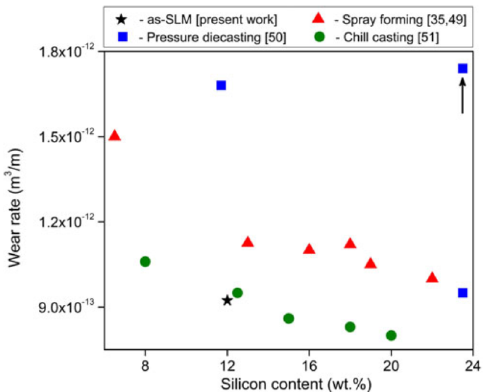
Figure 69. Wear rates of Al-Si alloys produced by different techniques as a function of the Si content